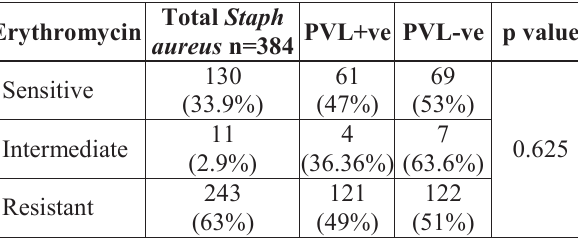
Table-2: Erythromycin and PVL gene